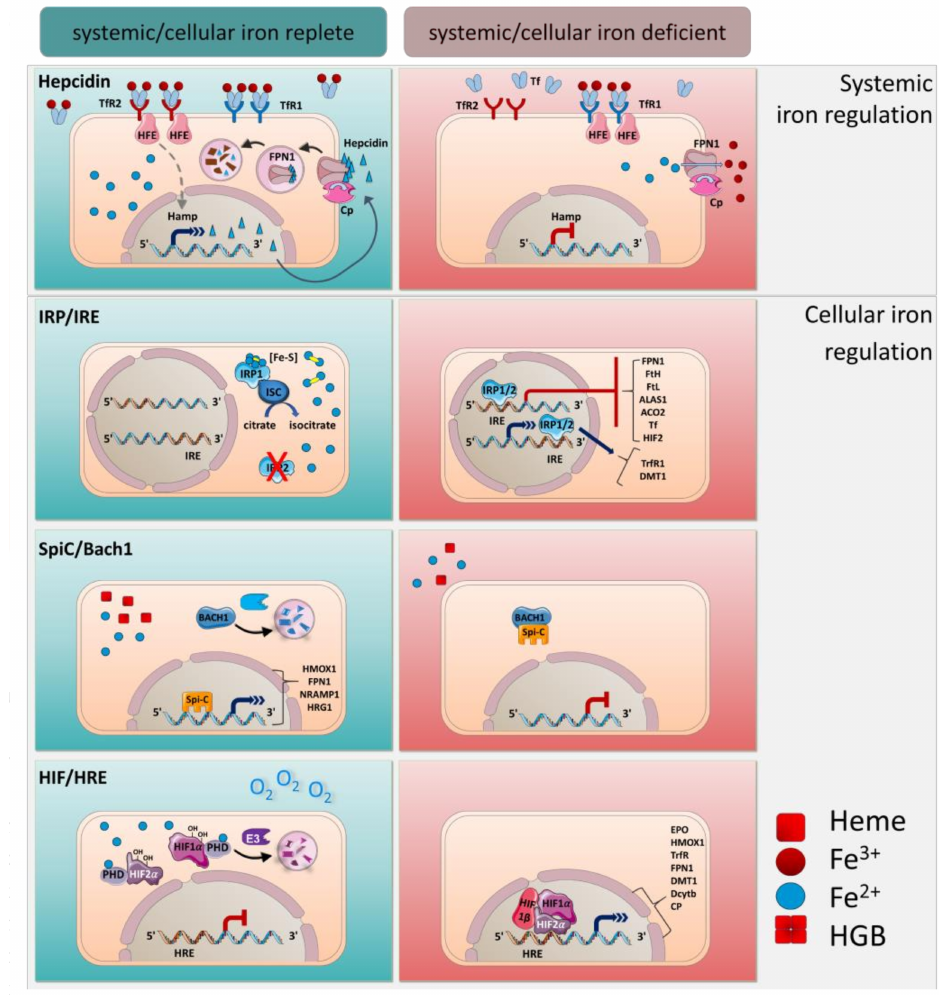
Figure 2. Main regulatory mechanisms of iron. Regulation of iron metabolism through hepcidin, the IRP/IRE, Spi-C/Bach1, and HIF/HRE. For details see